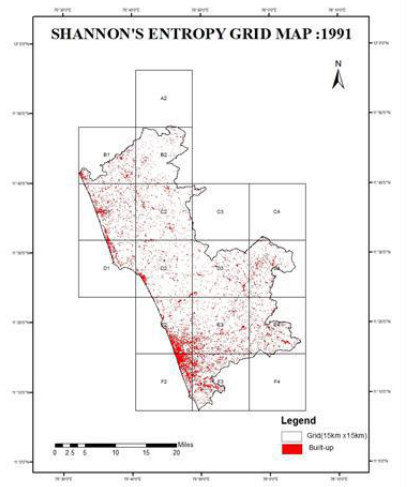
Figure 6: Shannon’s Entropy Grid Map of Study